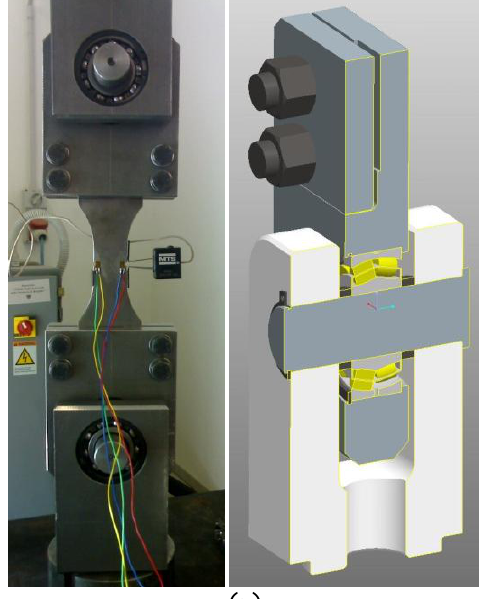
closed cell mounted on a specimen during the